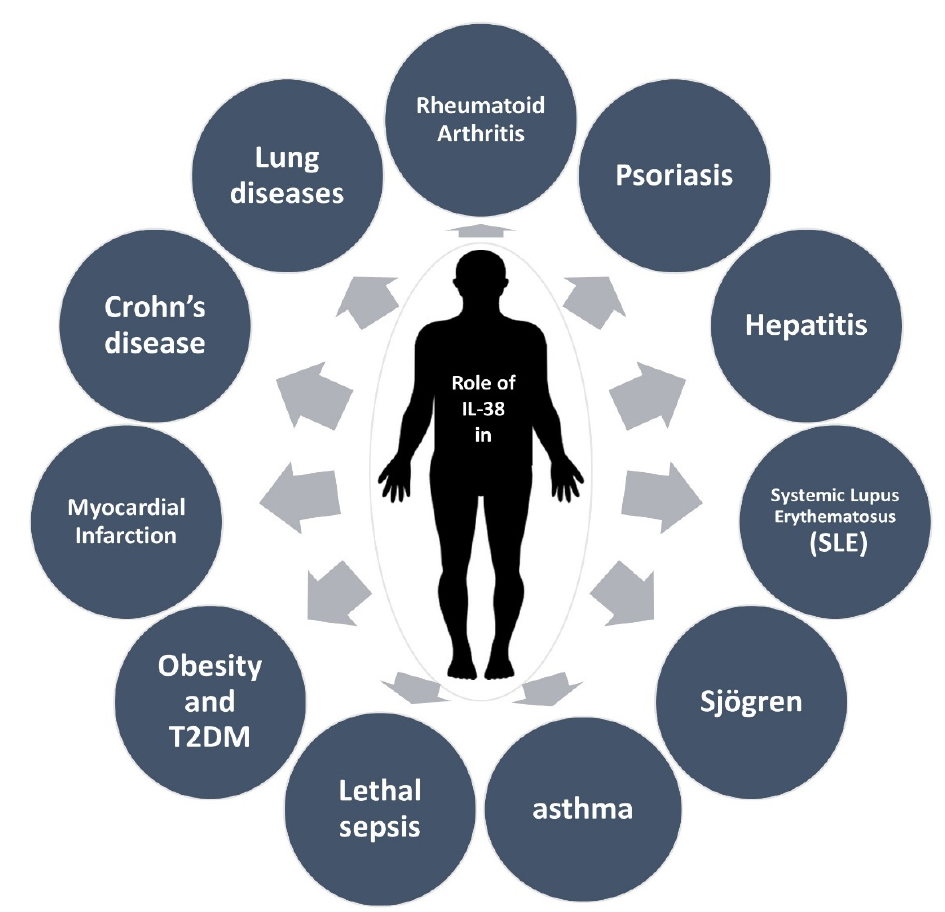
Figure 1. Involvement of IL-38 in immune-mediated diseases. Created by Esmaeilzadeh et al.